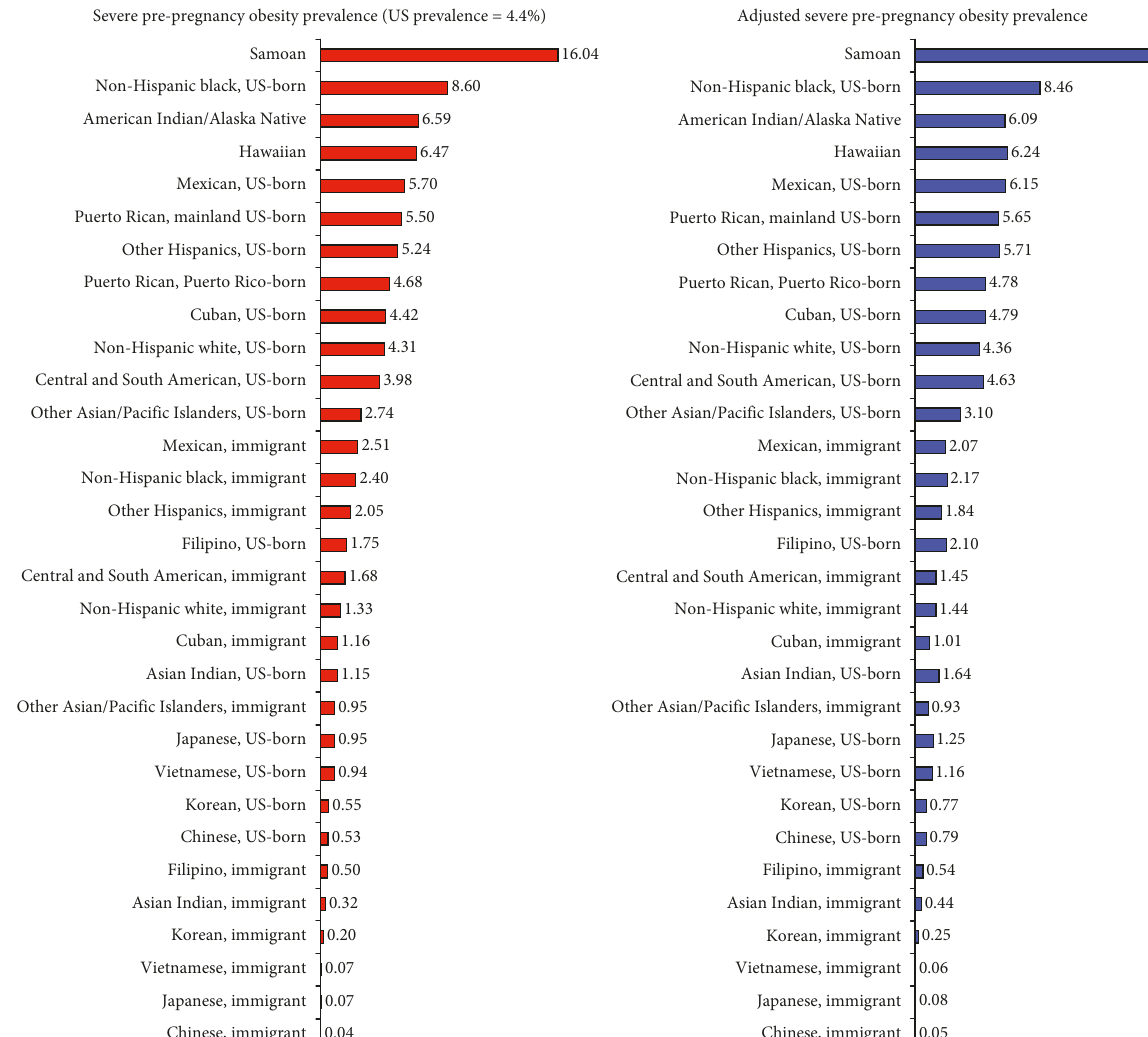
Figure 2: Ethnic-immigrant disparities in observed and adjusted 1 prevalence (%) of severe pre-pregnancy obesity (BMI ≥ 40) among US women, 2012–2014. 1 Adjusted for maternal age, parity, marital status, maternal education, and place and region of